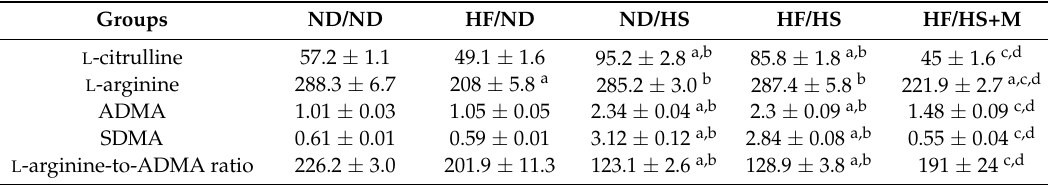
ADMA, asymmetric dimethylarginine; SDMA, symmetric dimethylarginine; HF/ND, maternal high fructose intake; ND/HS, post-weaning high salt intake; HF/HS, maternal high fructose intake plus post-weaning high salt intake; HF/HS+M, maternal high fructose intake plus post-weaning high salt intake and treated with melatonin; a p < 0.05 vs. ND/ND; b p < 0.05 vs. HF/ND; c p < 0.05 vs. ND/HS; d p < 0.05 vs.